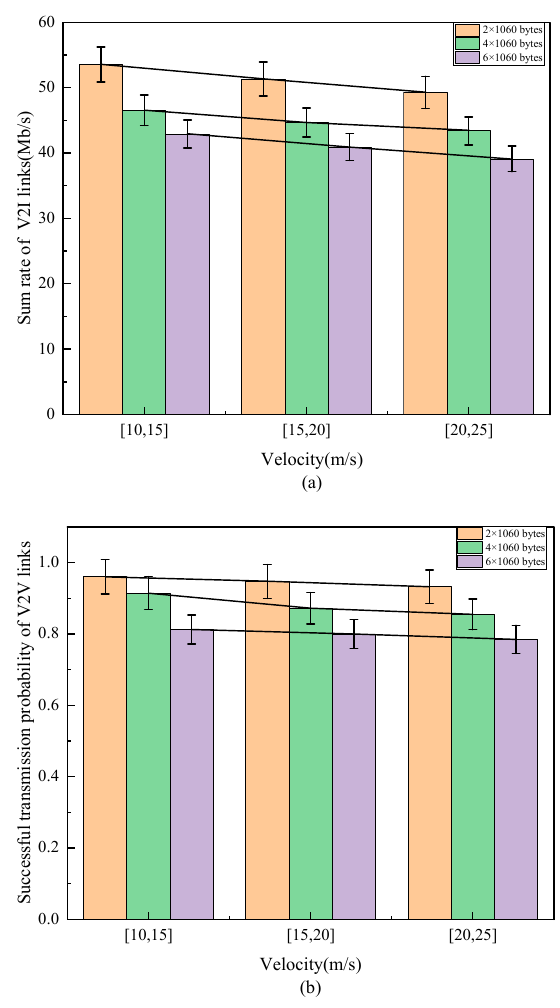
Figure 7. The performance comparison different velocity: ( a ) Sum rate of V2I links. ( b ) Successful transmission probability of V2V links.